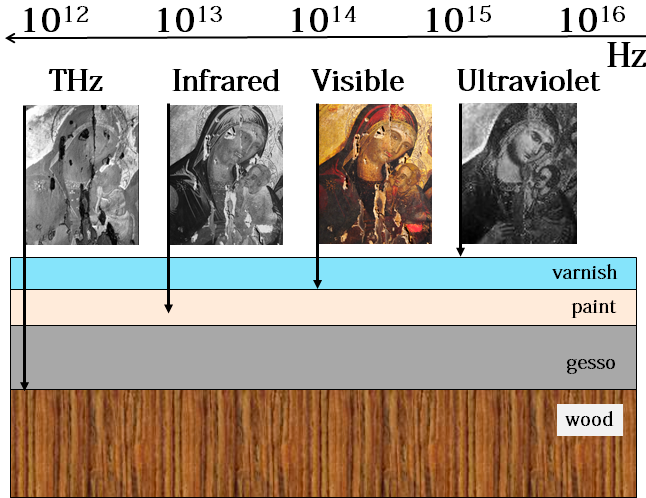
Figure 1. Terahertz radiation (10 12 Hz) is often applied for the study of paintings. Terahertz ( THz) and X-ray radiography can penetrate a panel painting deeper than other radiations traditionally used for paintings examination, such as infrared, but only THz allows for safe (non-ionizing) in deep 3D imaging of its